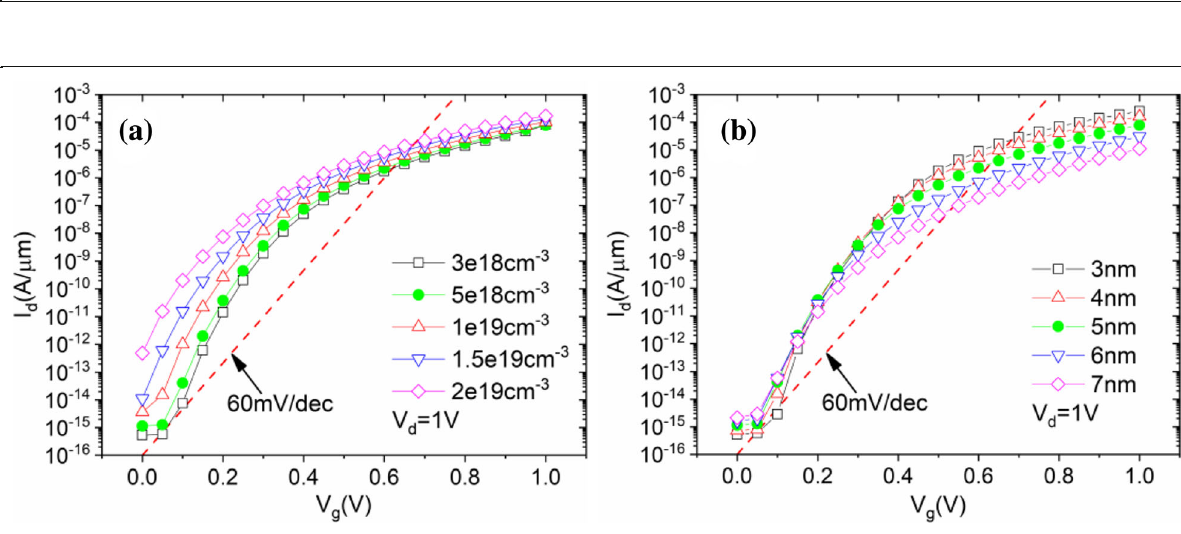
Fig. 6 Simulated drain currents with different n+ pocket a concentrations and b thicknesses at V d = 1